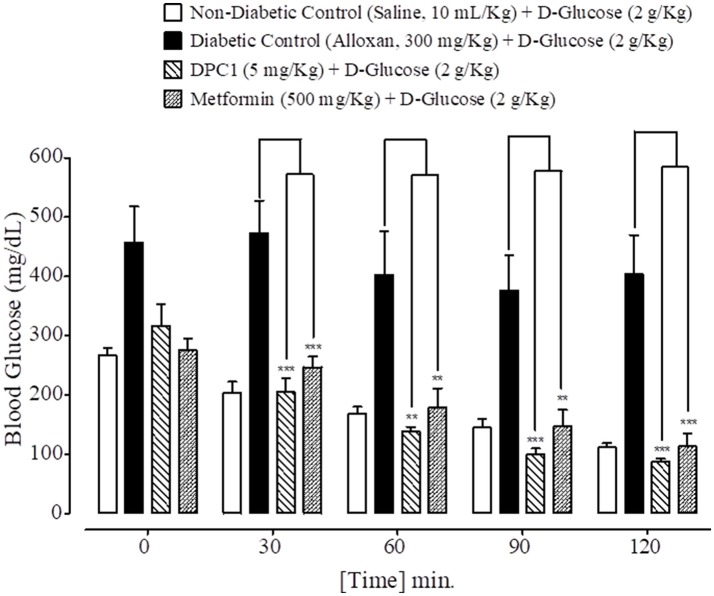
Bar graph representing blood glucose levels at different time intervals (0–120 min.) after administration of oral glucose load in mice of saline treated group (non-diabetic control), alloxan treated group (diabetic control), 1-(4-chlorobenzoyl)-3-(4-ferrocenylphenyl) urea (DPC1) treated group and metformin treated group. Data expressed as mean ± SEM. Statistical analysis used one-way ANOVA, followed by post-hoc Tukey's test. **P < 0.01, ***P < 0.001 comparison of the blood glucose levels of DPC1 and metformin treated group vs. diabetic control group. The sample size in each group comprised of five mice (n = 5).